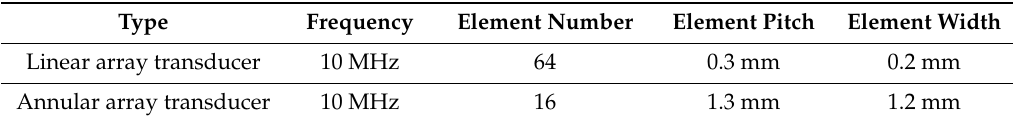
Table 1. Parameters of the array